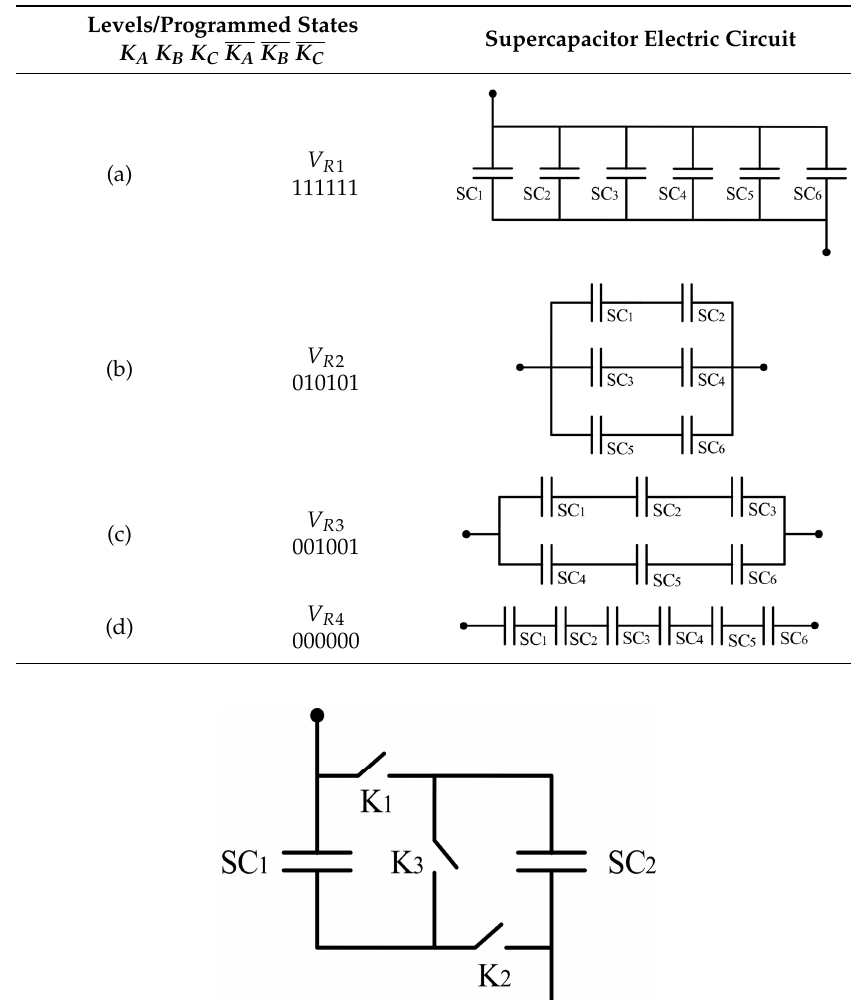
Table 1. Programmed states of the SCB.